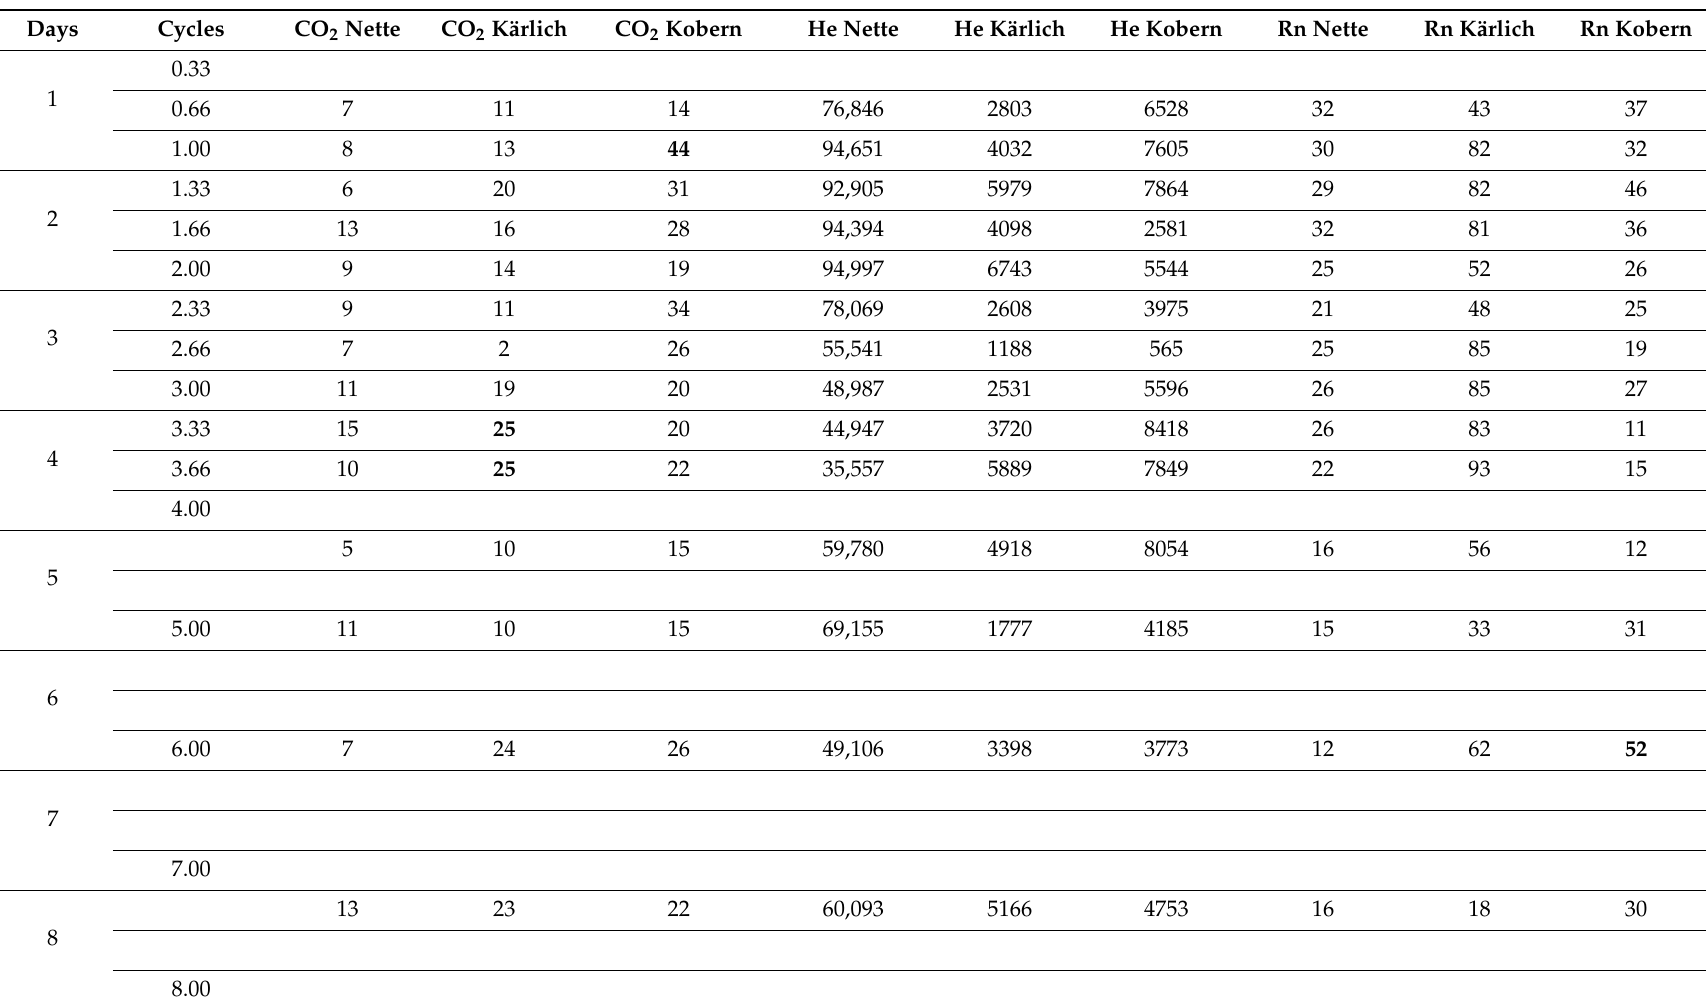
Table A2. Fourier Transform (FT) for CO 2 , He and Rn in mineral waters (4-W sampling). Maxima of amplitudes are highlighted in